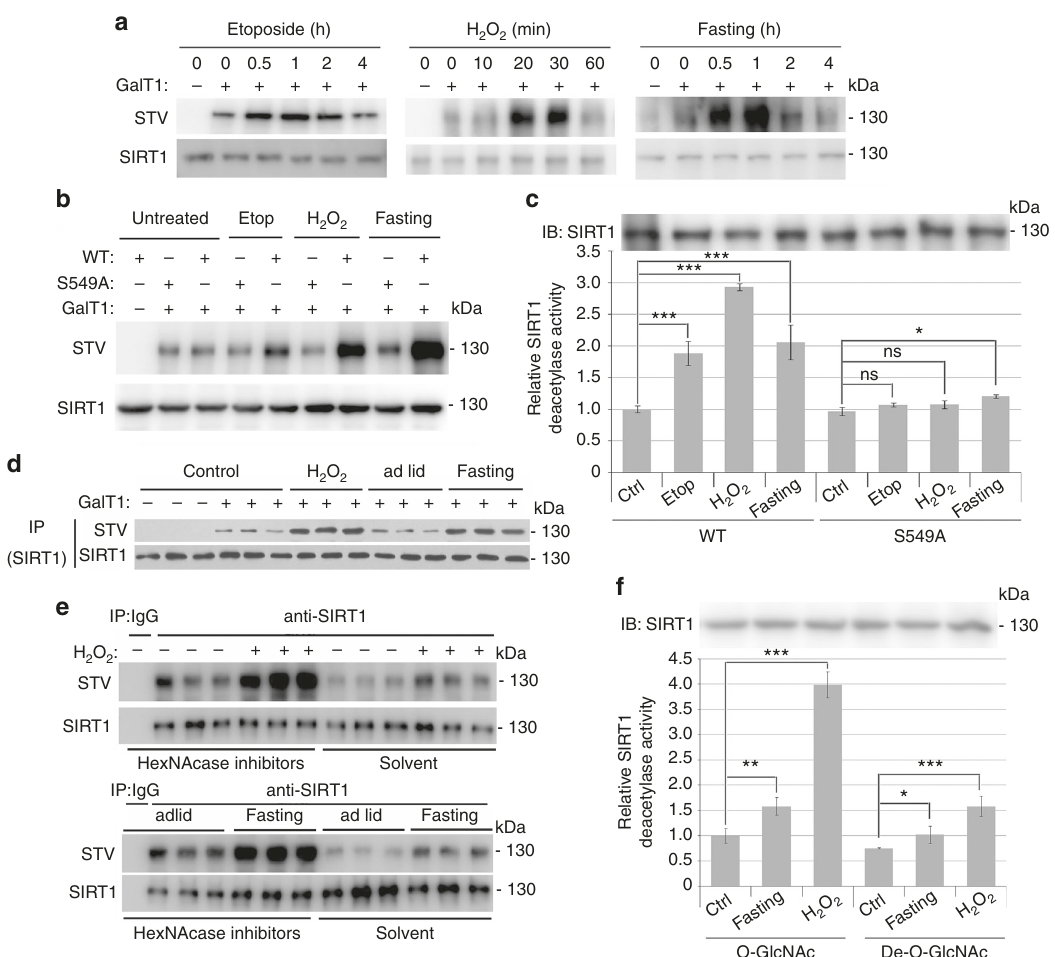
Fig. 5 Stress stimuli induced O-GlcNAcylation and activation of SIRT1. a Stress stimuli induced SIRT1 O-GlcNAcylation in a time-dependent manner in NCI- H1299 cells (top). NCI-H1299 cells were stimulated with etoposide (25 μ M), H 2 O 2 (200 μ M) or glucose depletion (fasting) for the indicated times and